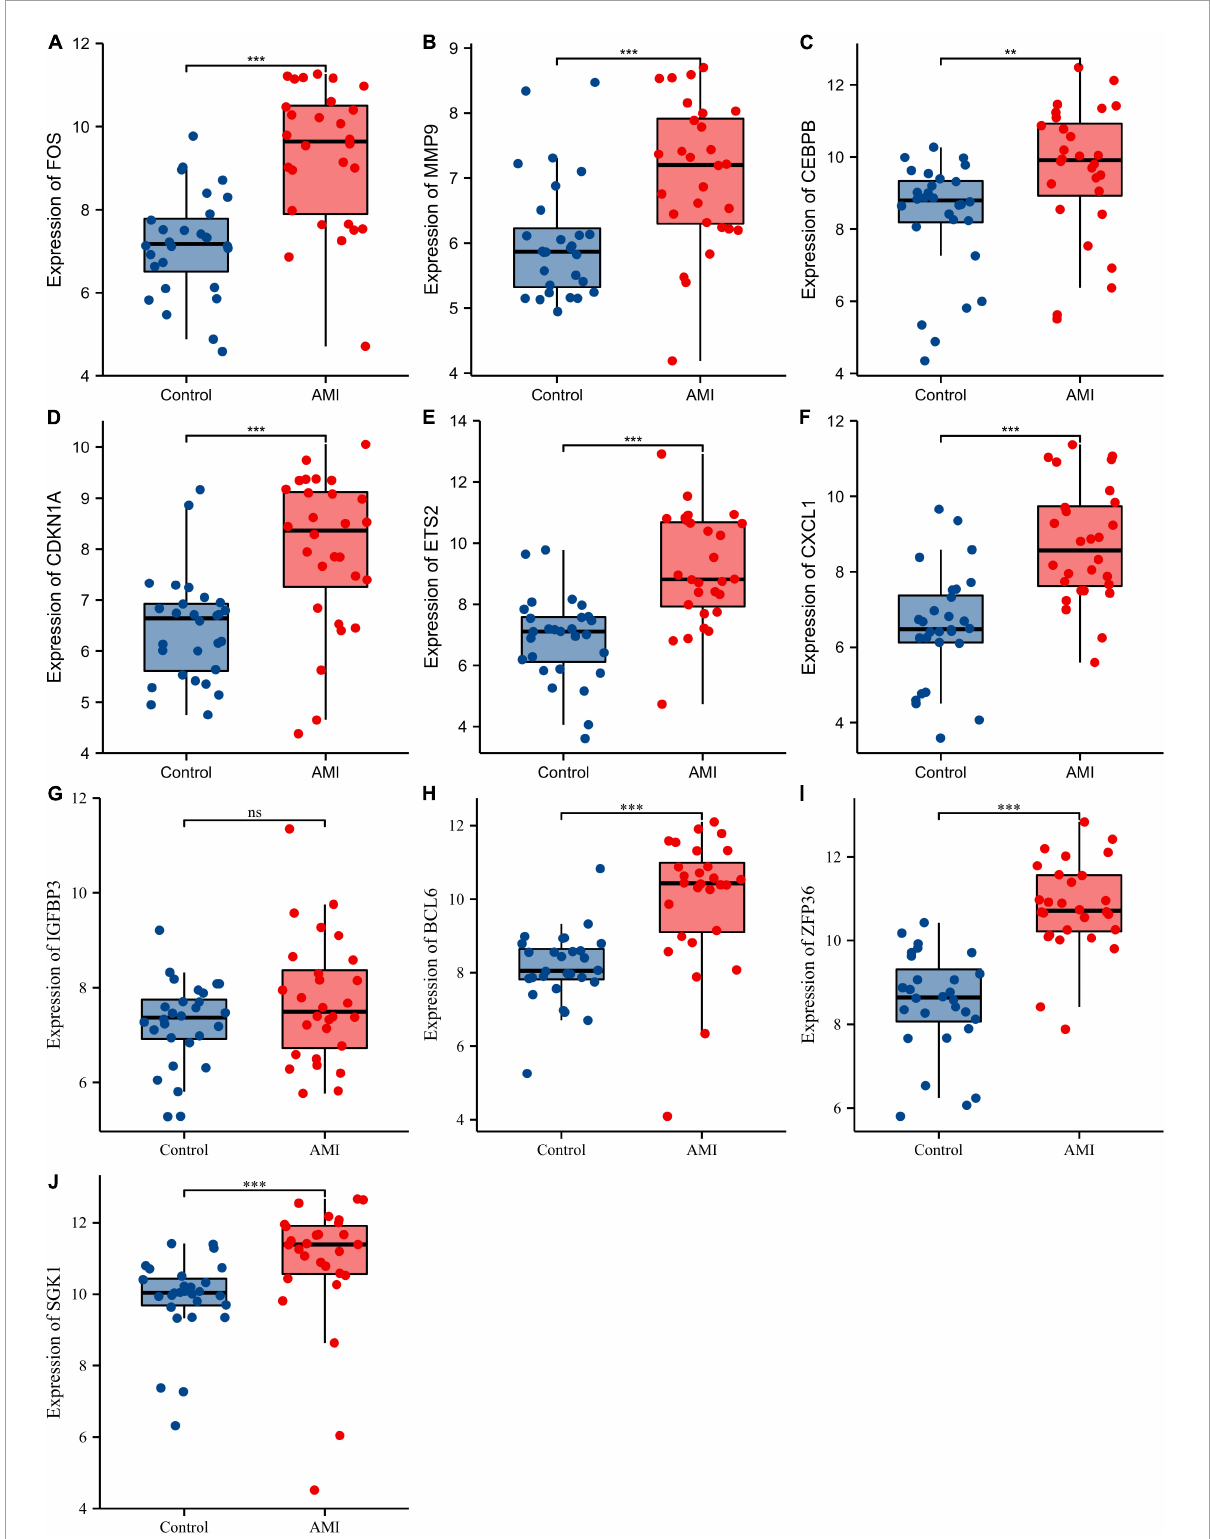
FIGURE9 Comparison of the expression of 10 hub genes in the GSE66360 validation set. Expression levels of FOS (A) , MMP9 (B) , CEBPB (C) , CDKN1A (D) , ETS2 (E) , CXCL1 (F) , IGFBP3 (G) , BCL6 (H) , ZFP36 (I) , and SGK1 (J) . ns, no significance; ∗∗ p < 0.01; ∗∗∗ p <